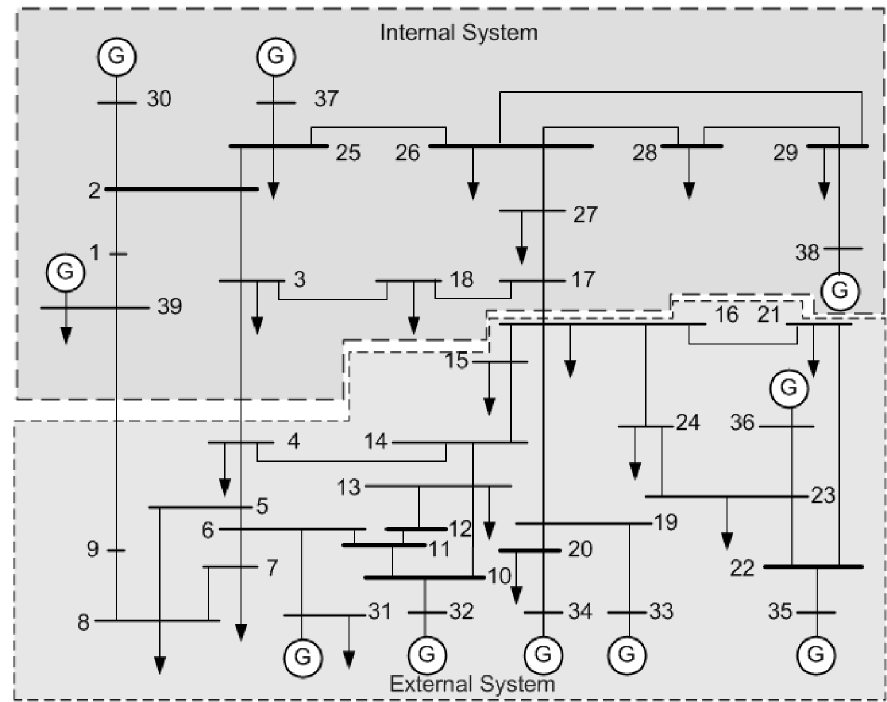
Figure 4. Division of the system into internal and external